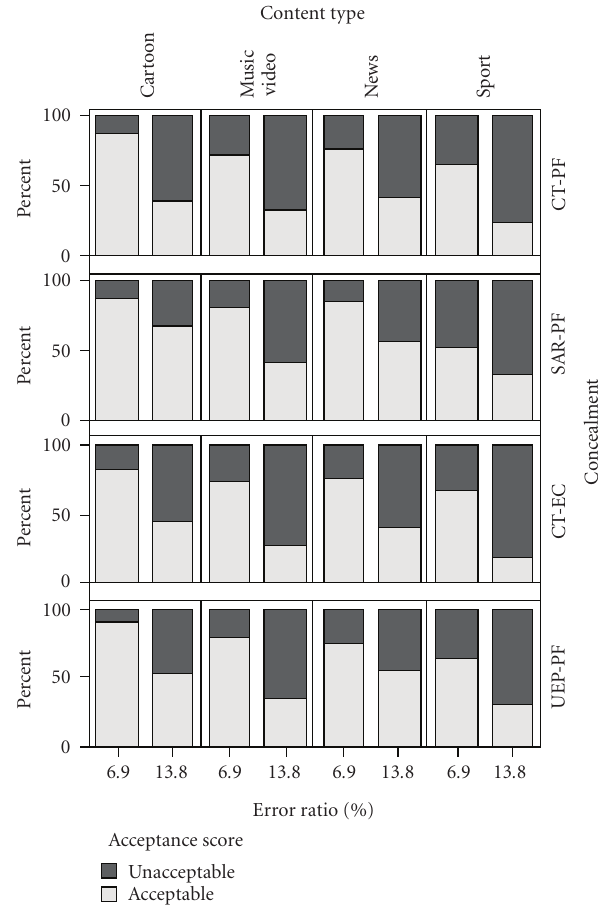
Figure 8: Retrospective acceptance of di ff erent error rates and concealment methods for all